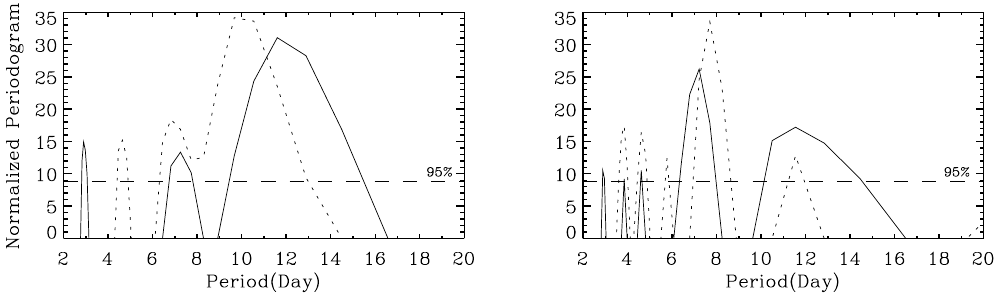
Fig. 17. Normalized Lomb-Scargle periodograms of diurnal tidal amplitudes at 19.0km in August 2006 (left) and at 5.0km in January 2007 (right). The solid and dotted curves denote those for the zonal and meridional wind amplitudes, respectively. The dashed horizontal lines denote the confidence level of 95%.